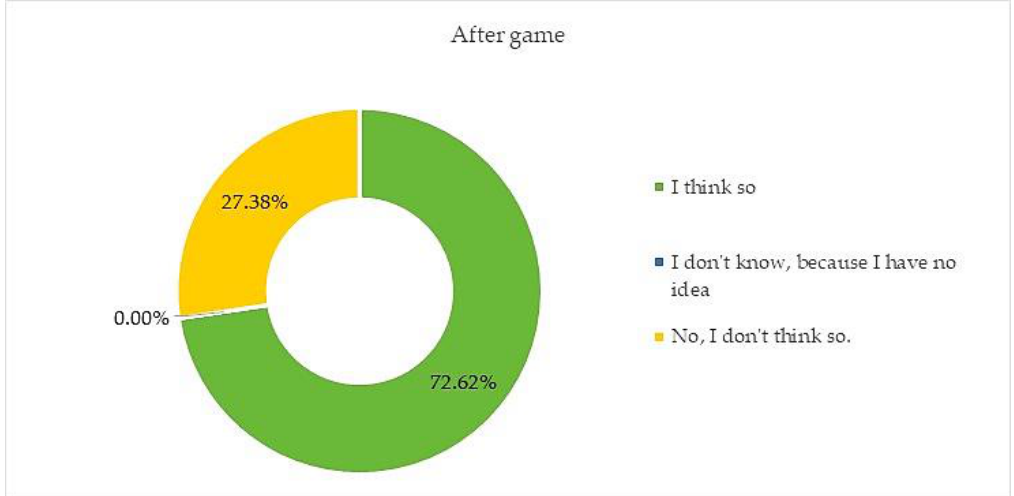
Figure 9. Results of questionnaire for question: Would the competition be more engaging if it included some tangible artifacts? (before using toolkit).